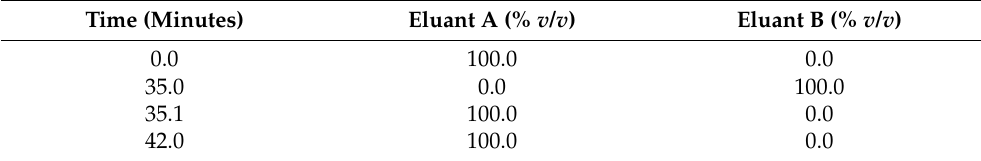
Table 3. HPLC gradient elution for lysozyme HCl analyses.